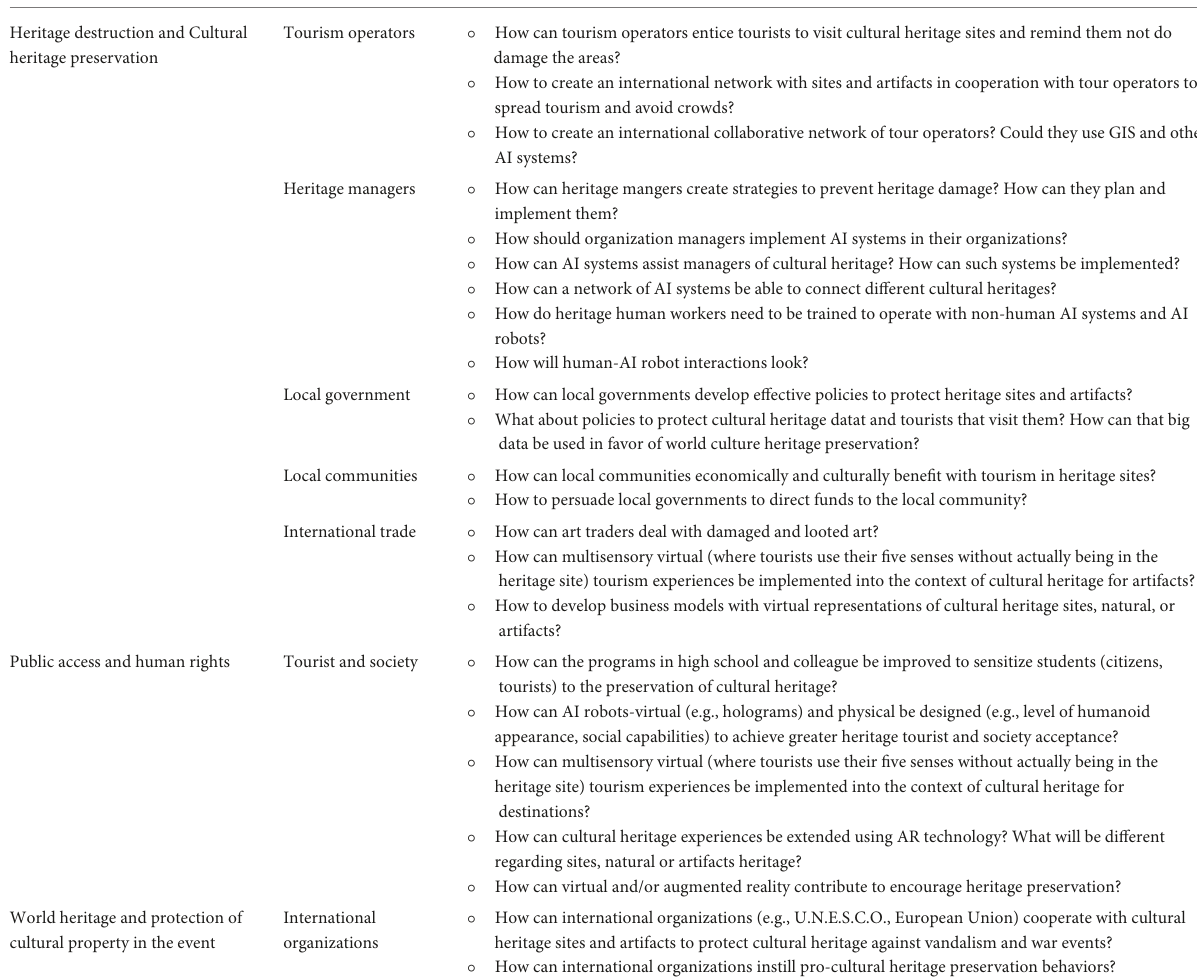
TABLE 1 Research suggestions. Cluster